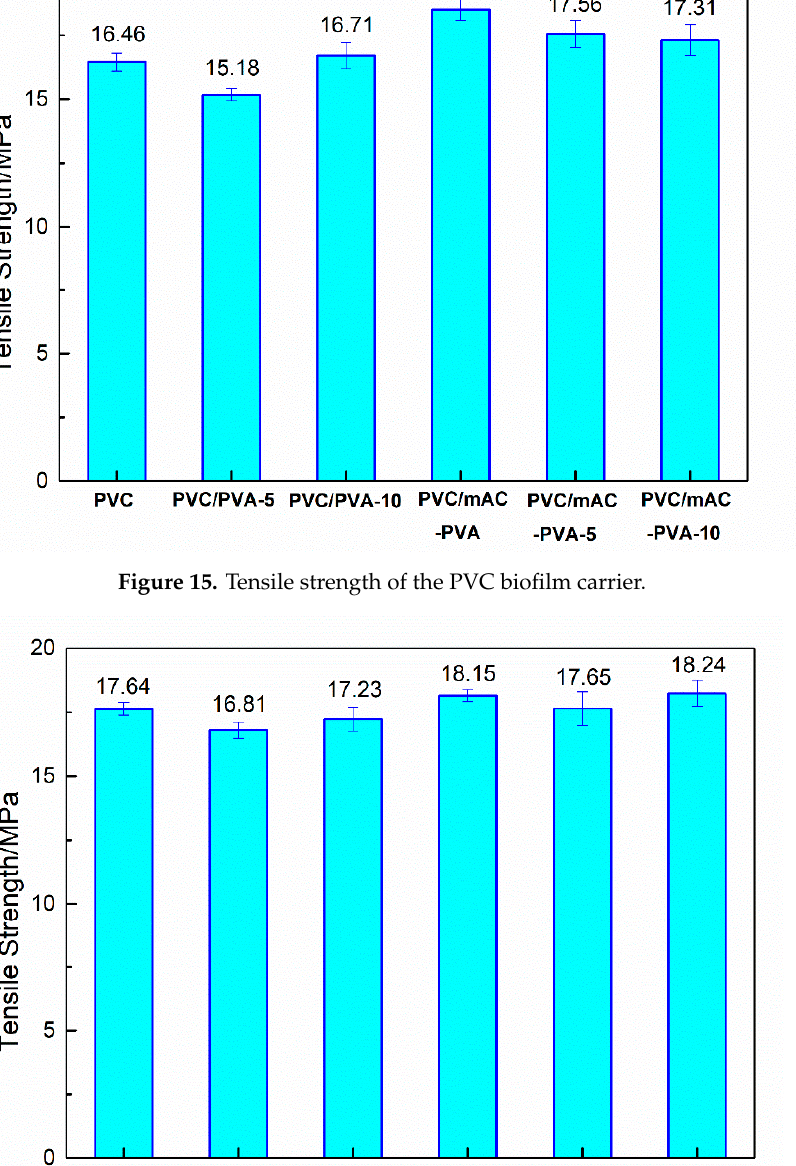
Figure 16. Tensile strength of the PVC modified by cPAM.